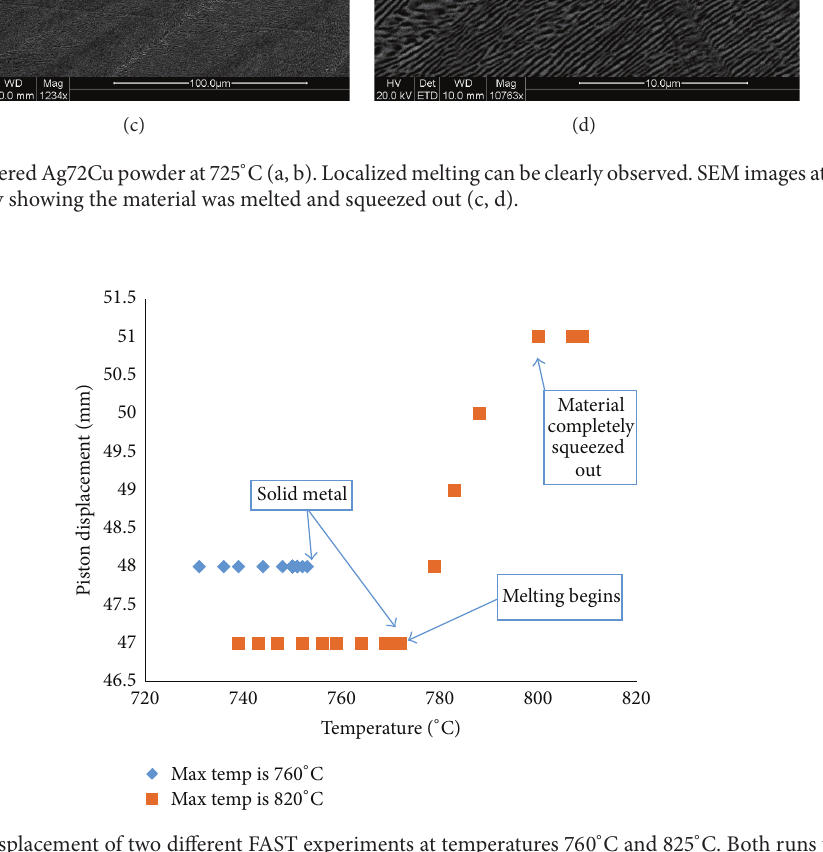
Figure 3: Graph of piston displacement of two different FAST experiments at temperatures 760 ∘ C and 825 ∘ C. Both runs were conducted at 50 ∘ C min −1 with a load of 45MPa. It is evident from the plot that the material quickly changes from solid to liquid at 780 ∘